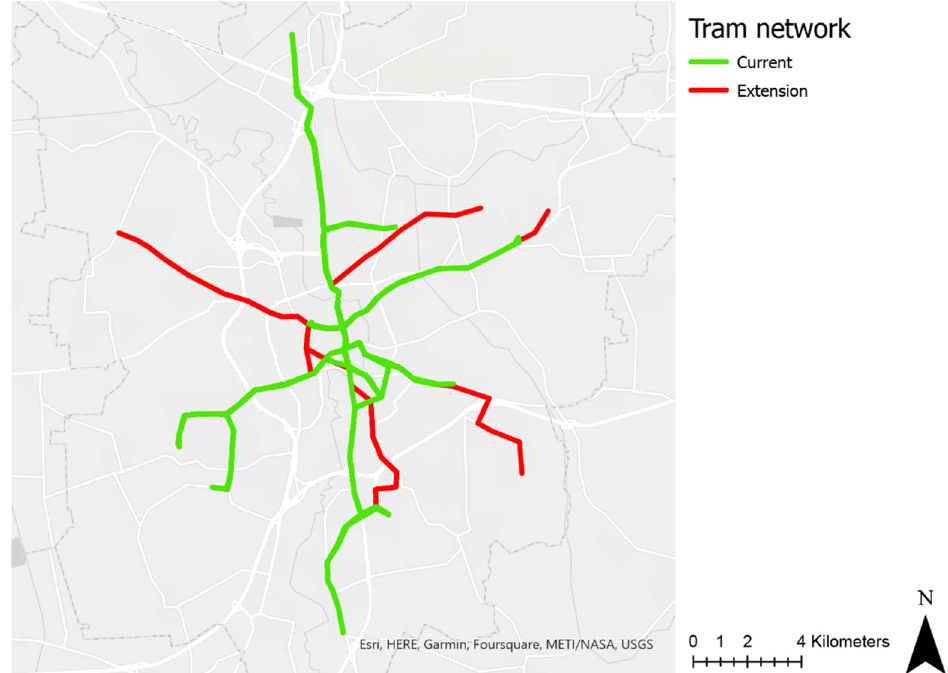
Figure 2. Current and planned tram networks in Braunschweig, Germany.